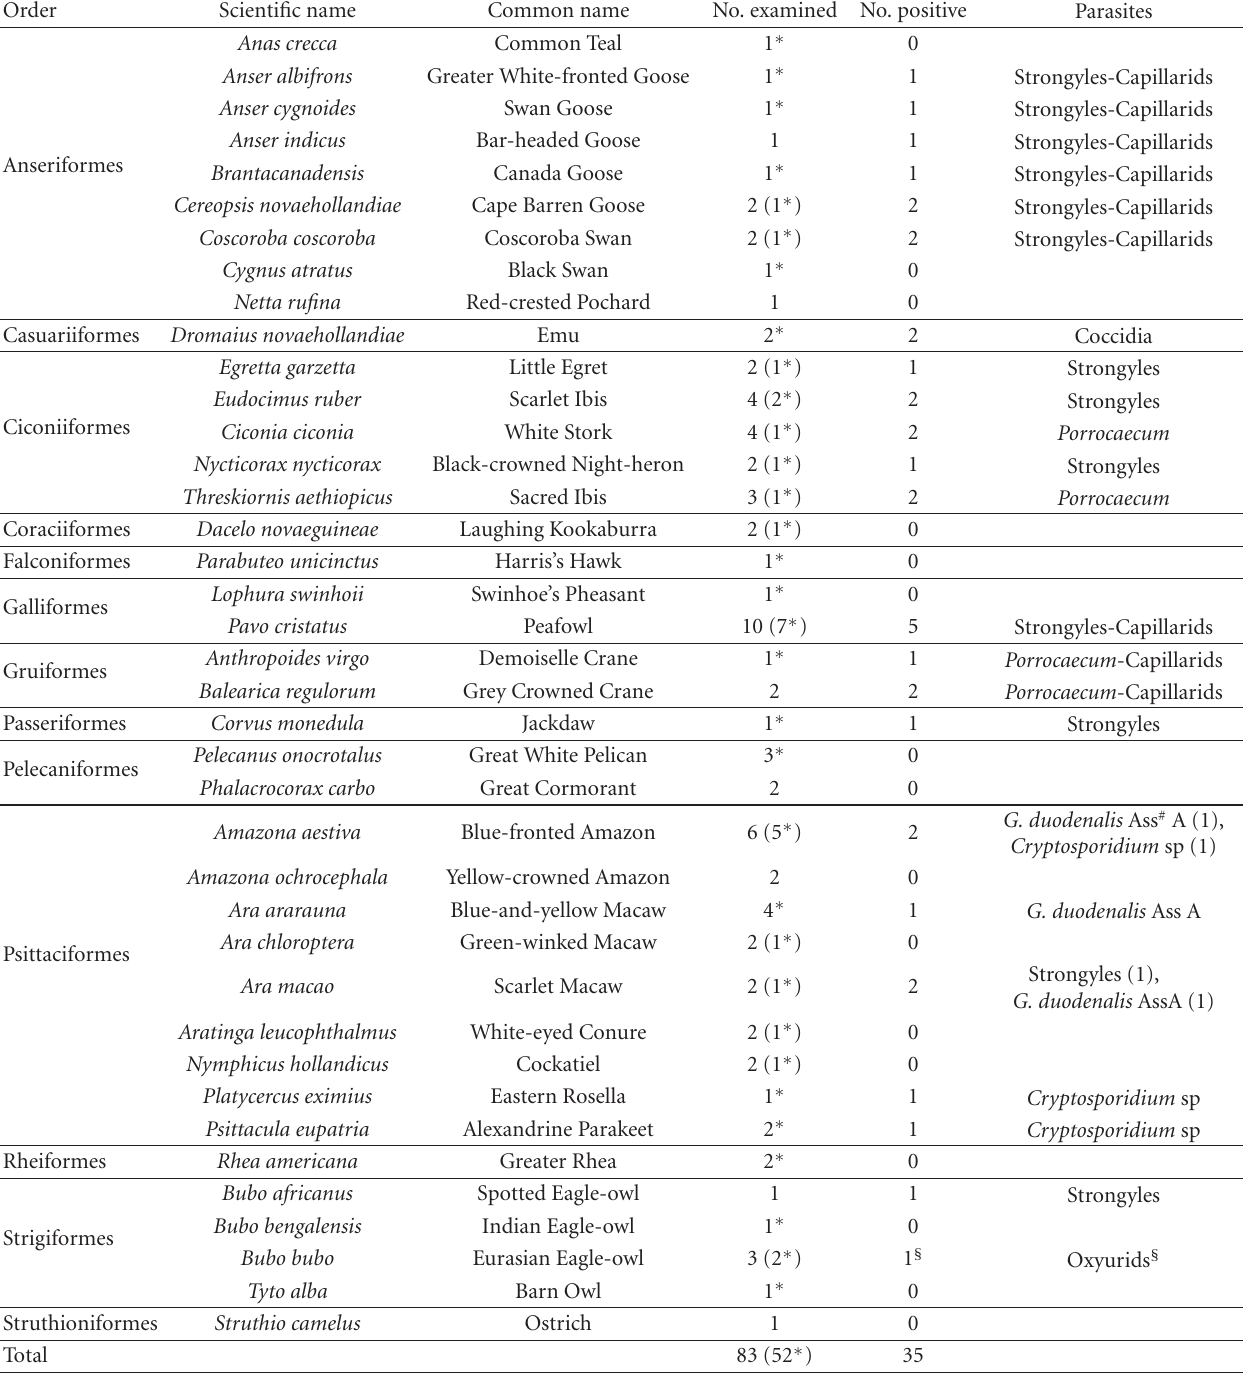
Table 2: Orders, scientific names, common names, numbers examined, positive numbers, and intestinal parasites found in zoo birds.